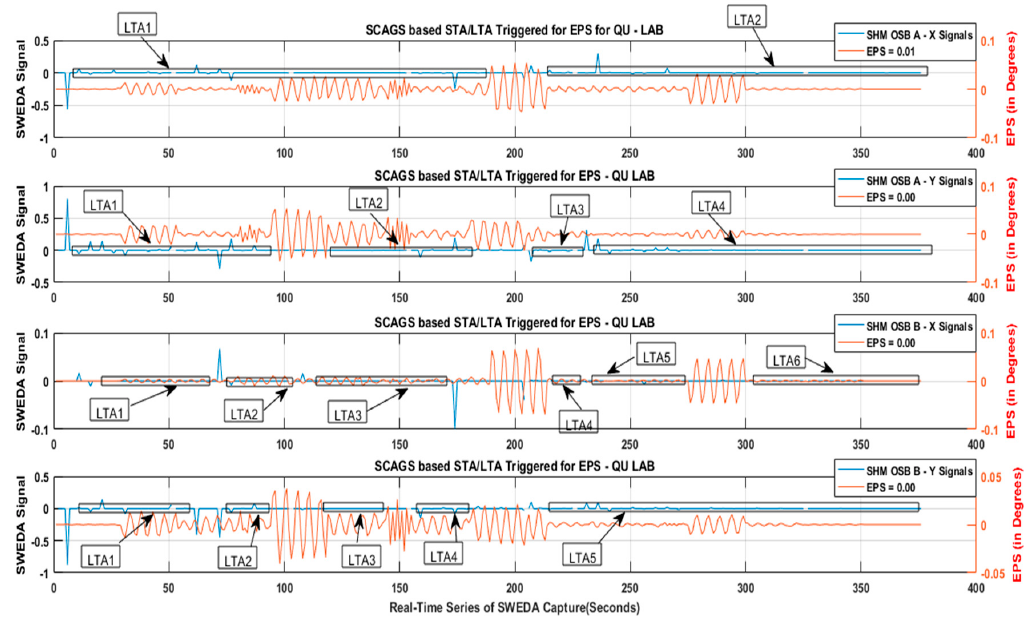
Figure 25. EPS for the assumed dataset (down-sampled to 400).